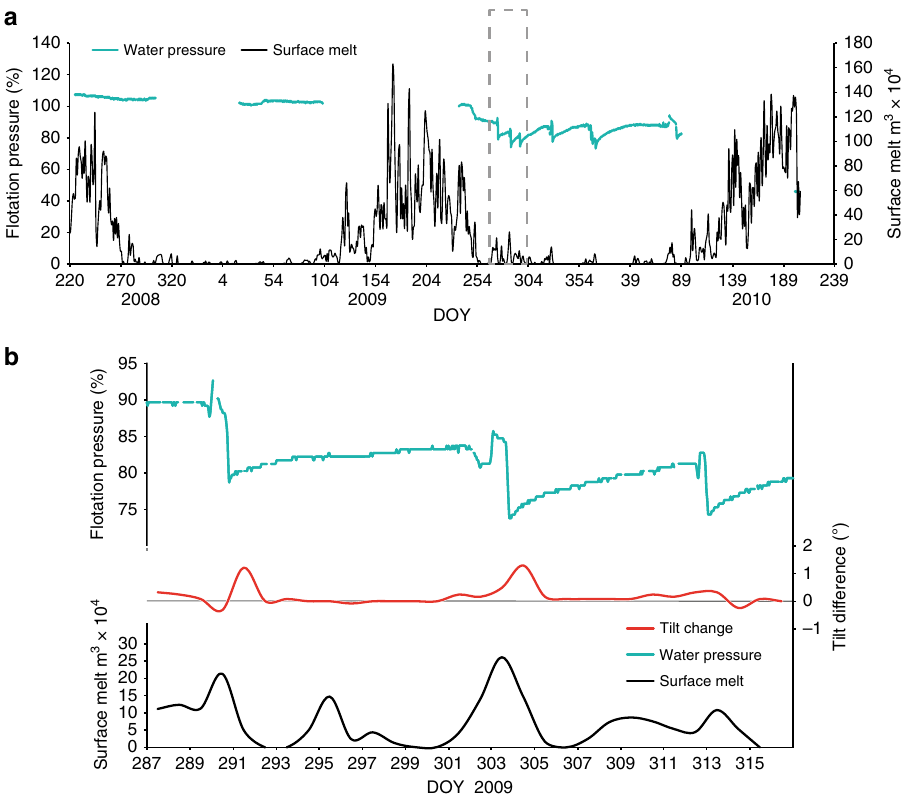
Fig. 3 Graphs showing the data from 2008 to 2010: a water pressure within the till and surface melt, 2008 – 2010 (the grey dashed box is enlarged in b ); b detail of water pressure, surface melt and change in tilt during two water pressure cycles day of year (DOY) 287 – 315 (2009)